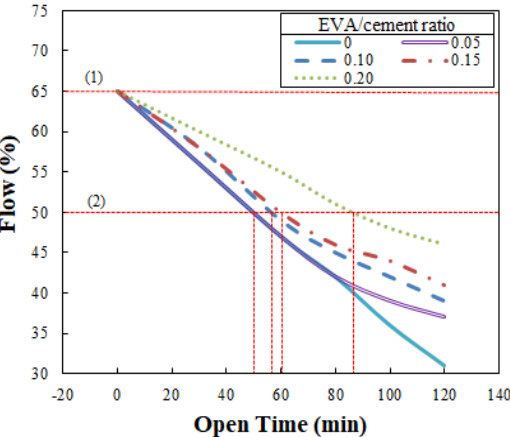
Figure 10. Determination of open time with the change of the flow: (1) reference point at 65% flow and (2) reference point at 50% flow.